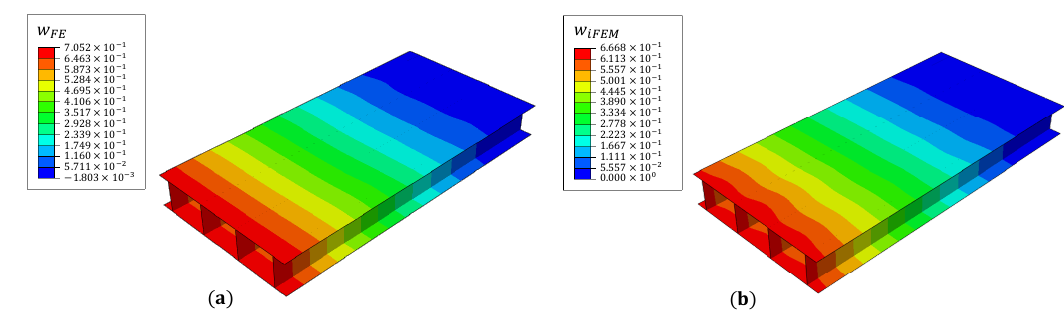
Figure 16. Deflection contours of ( a ) FE and ( b ) iFEM results for damage case 1 (units in mm).